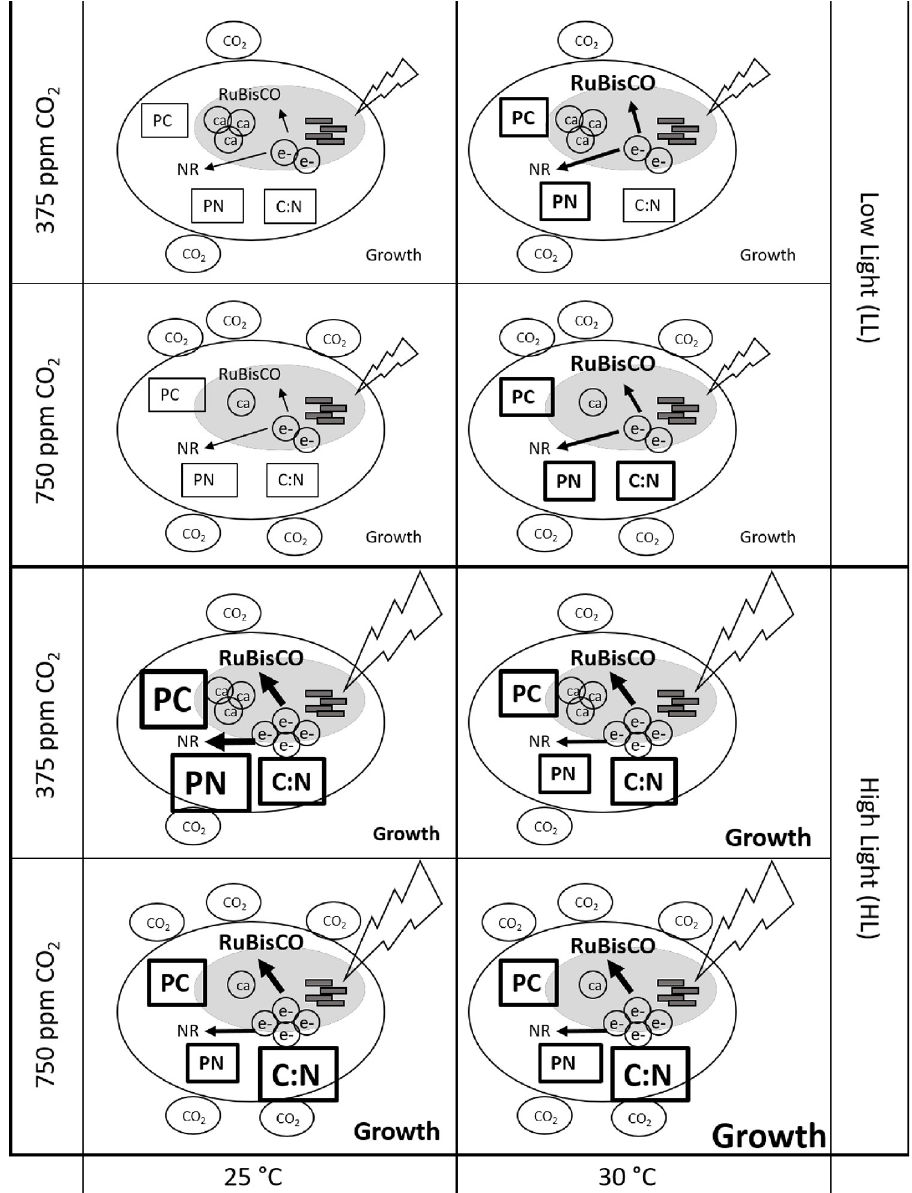
Fig 6. Illustration summarizing changes in measured parameters. Changes in particulate carbon and nitrogen, C:N ratios, growth and RuBisCO gene expression under ambient (375 ppm CO 2 , 25˚C), high CO 2 (750 ppm CO 2 , 25˚C), high temperature (375 ppm CO 2 , 30˚C), or combined high CO 2 and high temperature (750 ppm CO 2 , 30˚C) conditions in high light (HL) or low light (LL) intensities are shown. Increases in each parameter compared to ambient conditions under LL are indicated by bold font with further increases indicated by the size of the font. Darkened area within each cell represents the chloroplast. Ca, carbonic anhydrase; NR, nitrate reductase; e - , available reductant from light